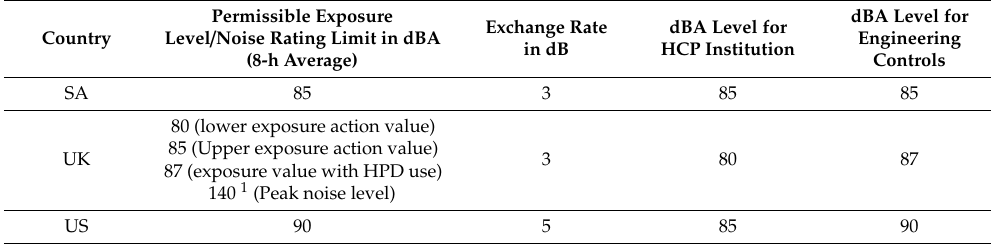
Table 2. Hearing conservation and control levels